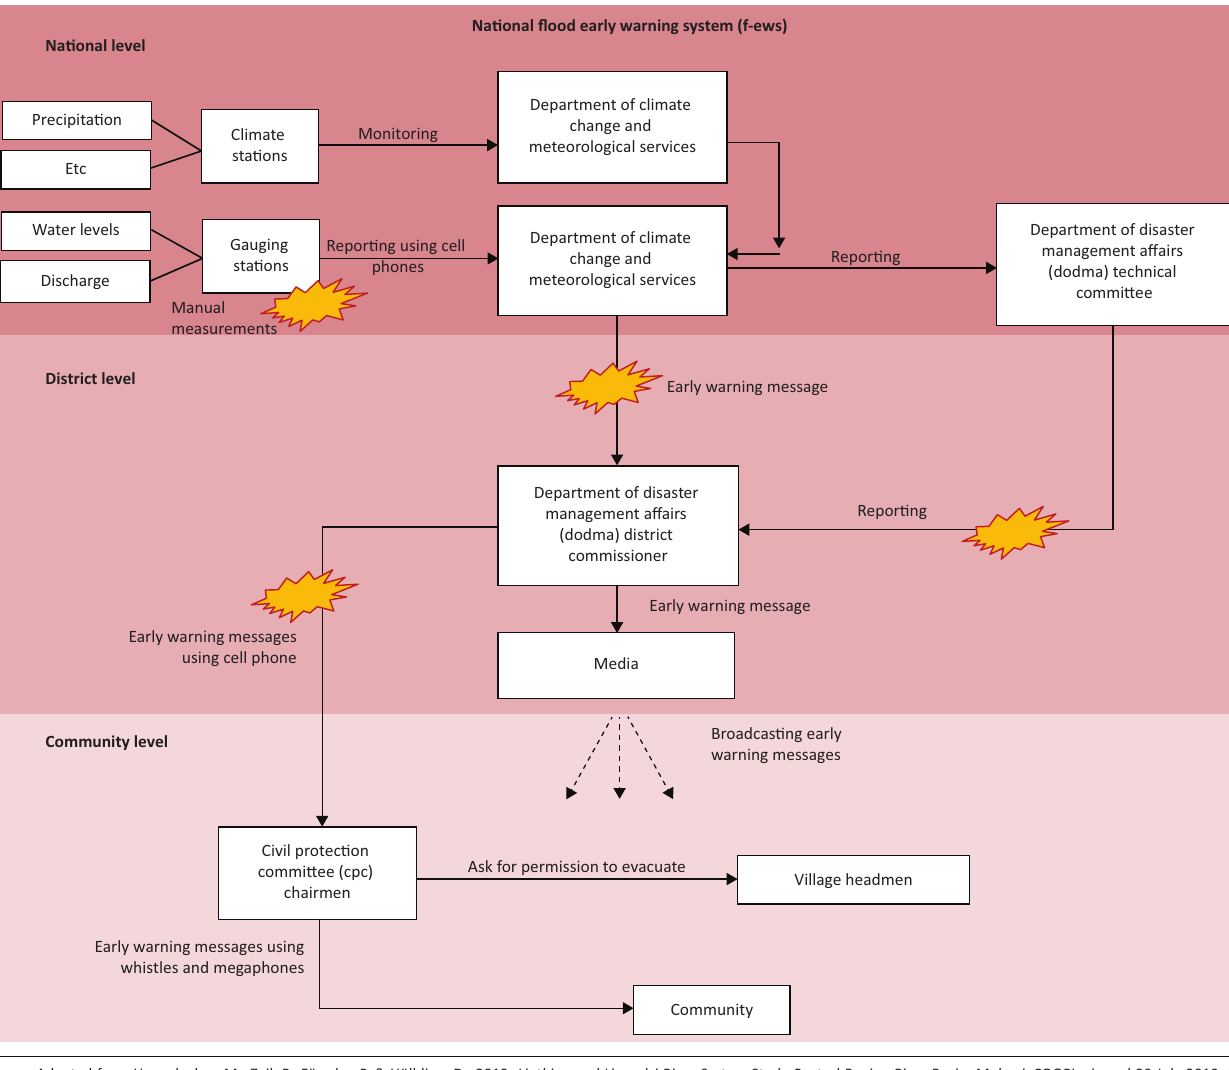
FIGURE 2: National flood early warning